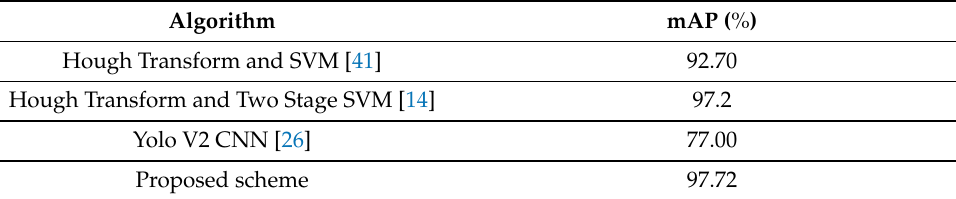
Table 5. Comparison with other staircase detection